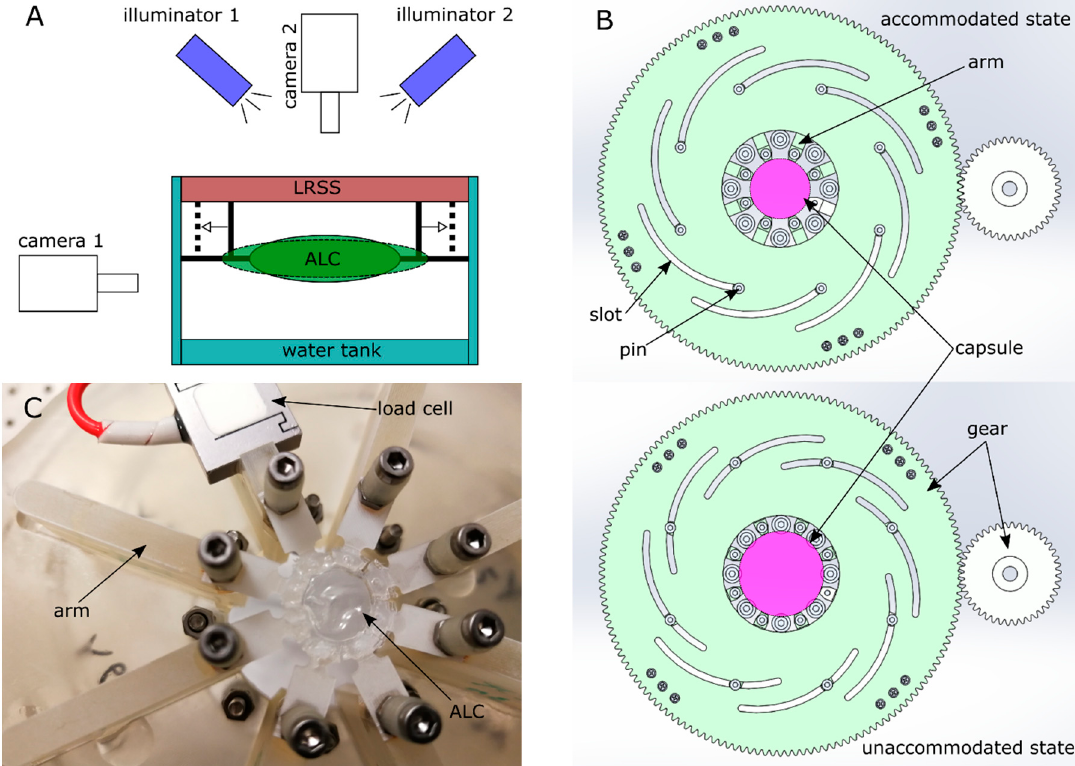
Figure 3. Experimental setup of the accommodating test: ( A ) illustration of the test scheme; ( B ) mechanism of the lens radial stretching system (LRSS); ( C ) integration of artificial lens capsule (ALC) to the LRSS.